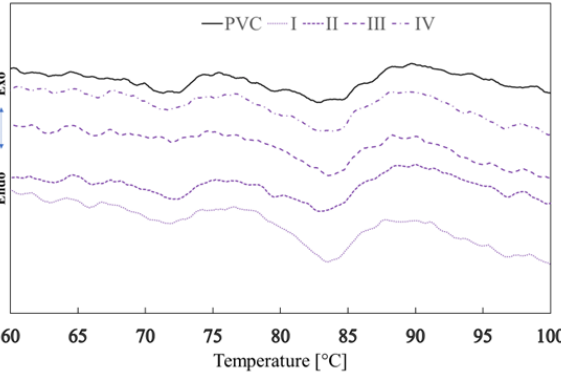
Figure 20. DSC curves for PVC and plasma treated PVC samples I, II, III a IV.